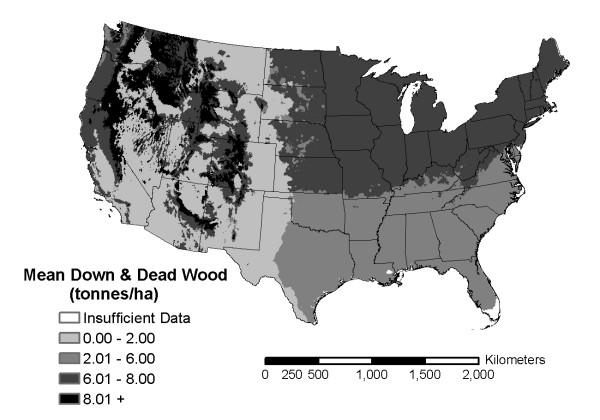
Continental U.S. Köppen climatic regions shaded by classes of mean total down woody C stocks.